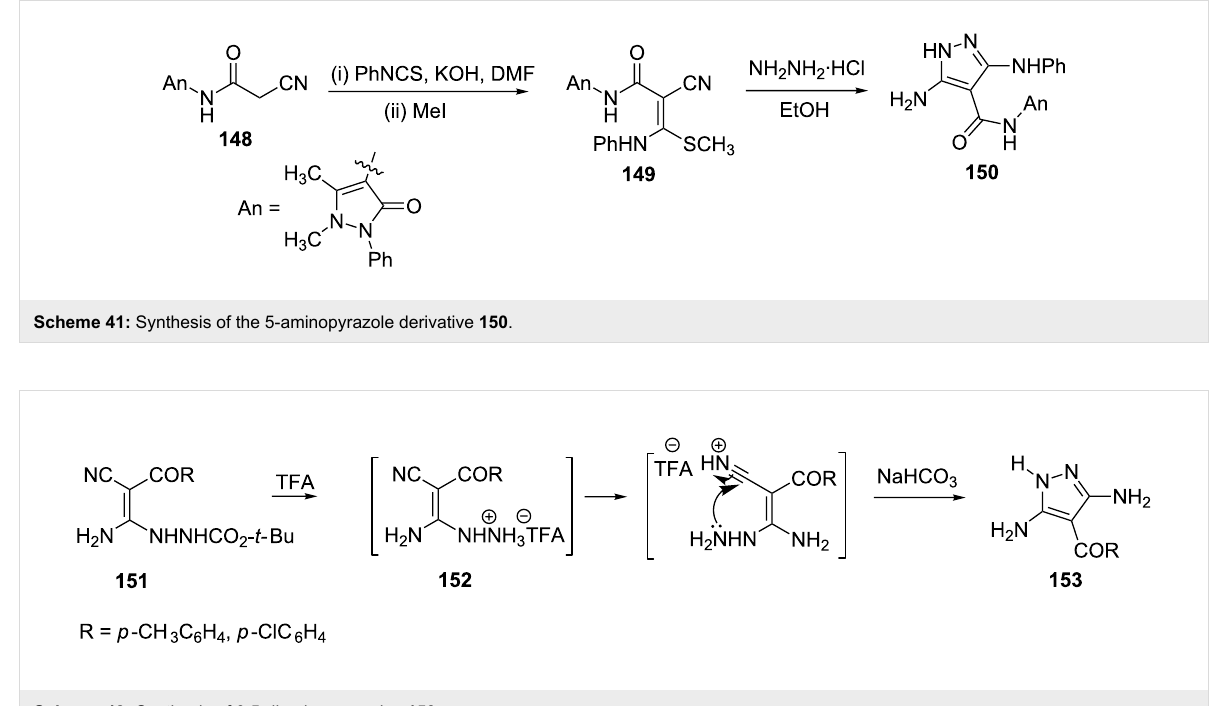
Scheme 42: Synthesis of 3,5-diaminopyrazoles 153 .